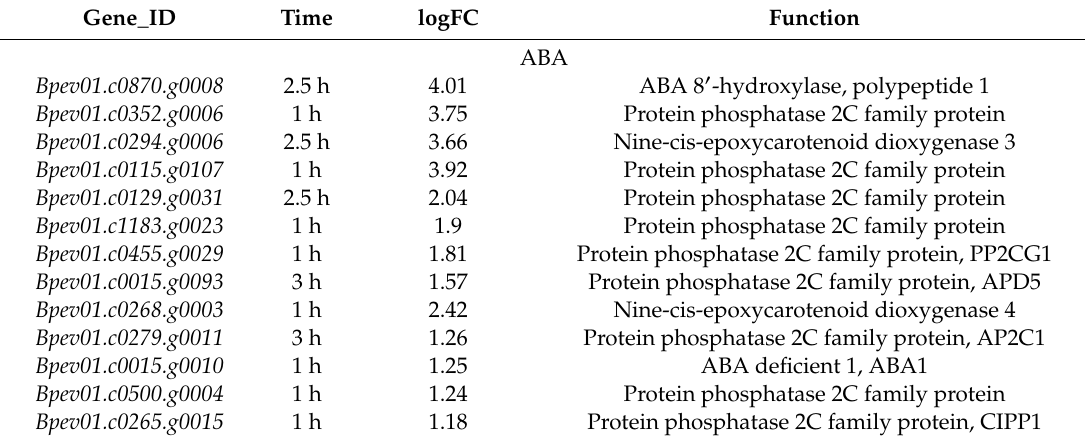
Table A5. Hormone-related DEGs under low temperature stress in